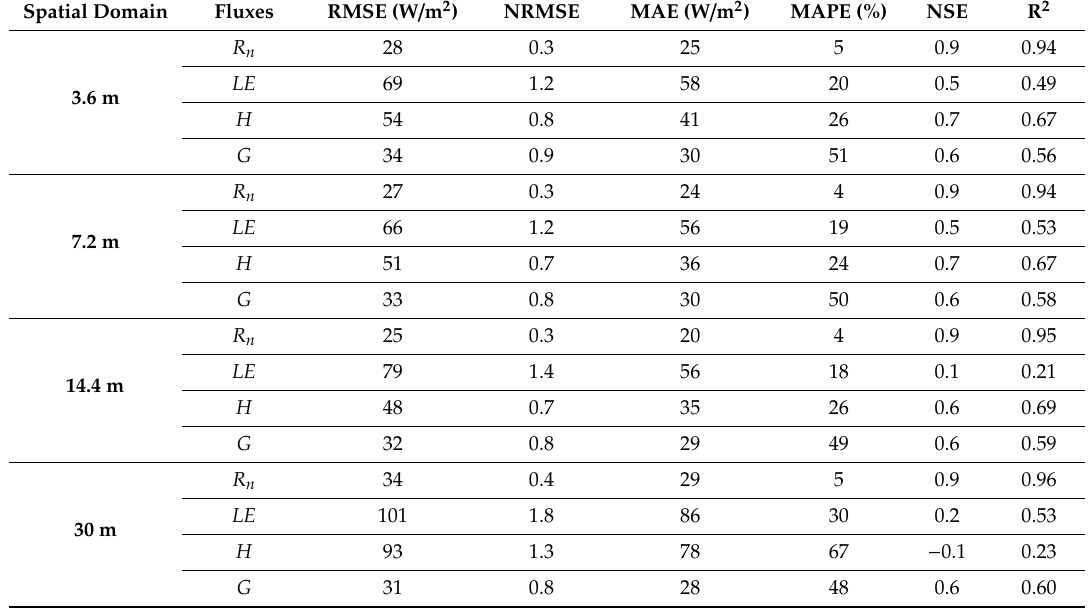
Table 3. Goodness-of-fit statistics between the eddy covariance and the TSEB2T fluxes at di ff erent spatial scales (3.6 m, 7.2 m, 14 m, and 30